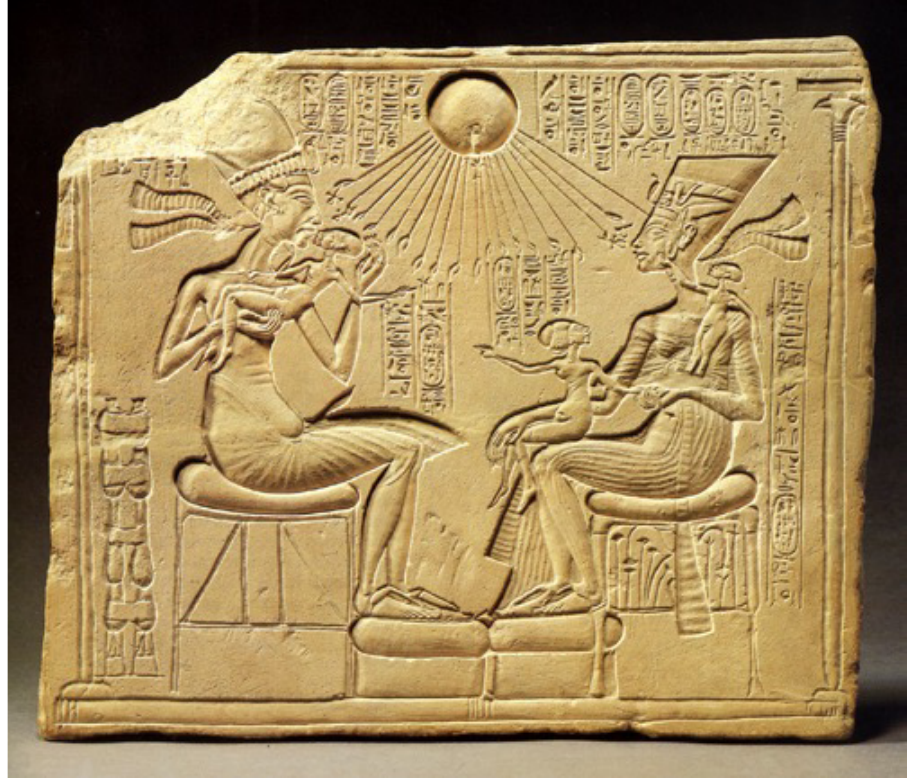
Figure 2. The “Berlin Stele.” A family portrait of Akhenaten, Nefertiti, and their daughters, 18 th Dynasty (Neues Museum,